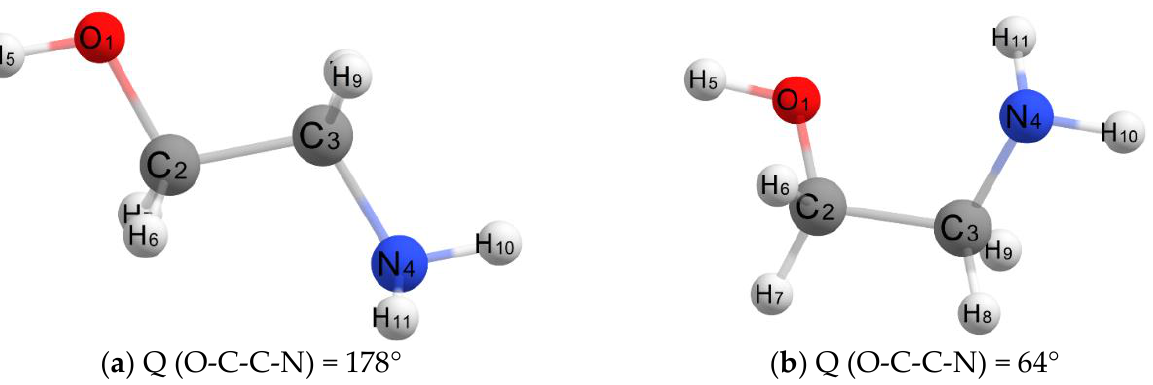
Figure 2. Models of two isomers of individual MEA molecules (transoidal ( a ) and gauche ( b ) structures).